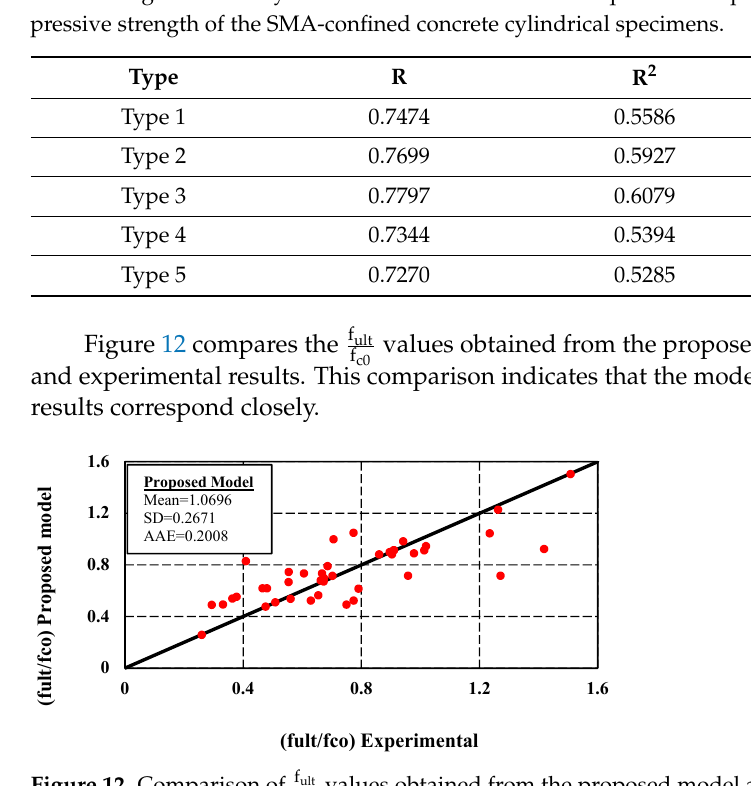
Figure 12. Comparison of